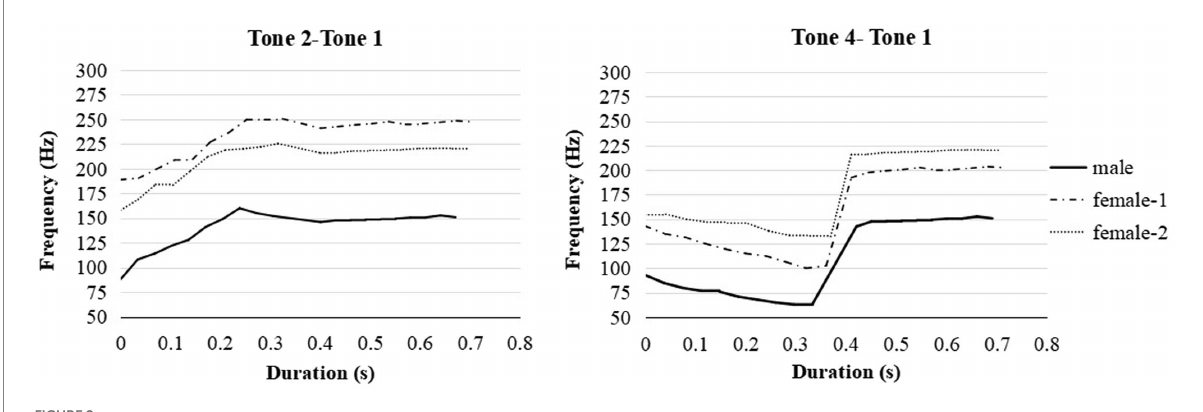
FIGURE 2 The pitch contours of disyllabic non-words produced by one male native speaker and two female native speakers in Cantonese. The pitch frequencies are averaged across /kasu/ − /tafu/ and /biso/ −